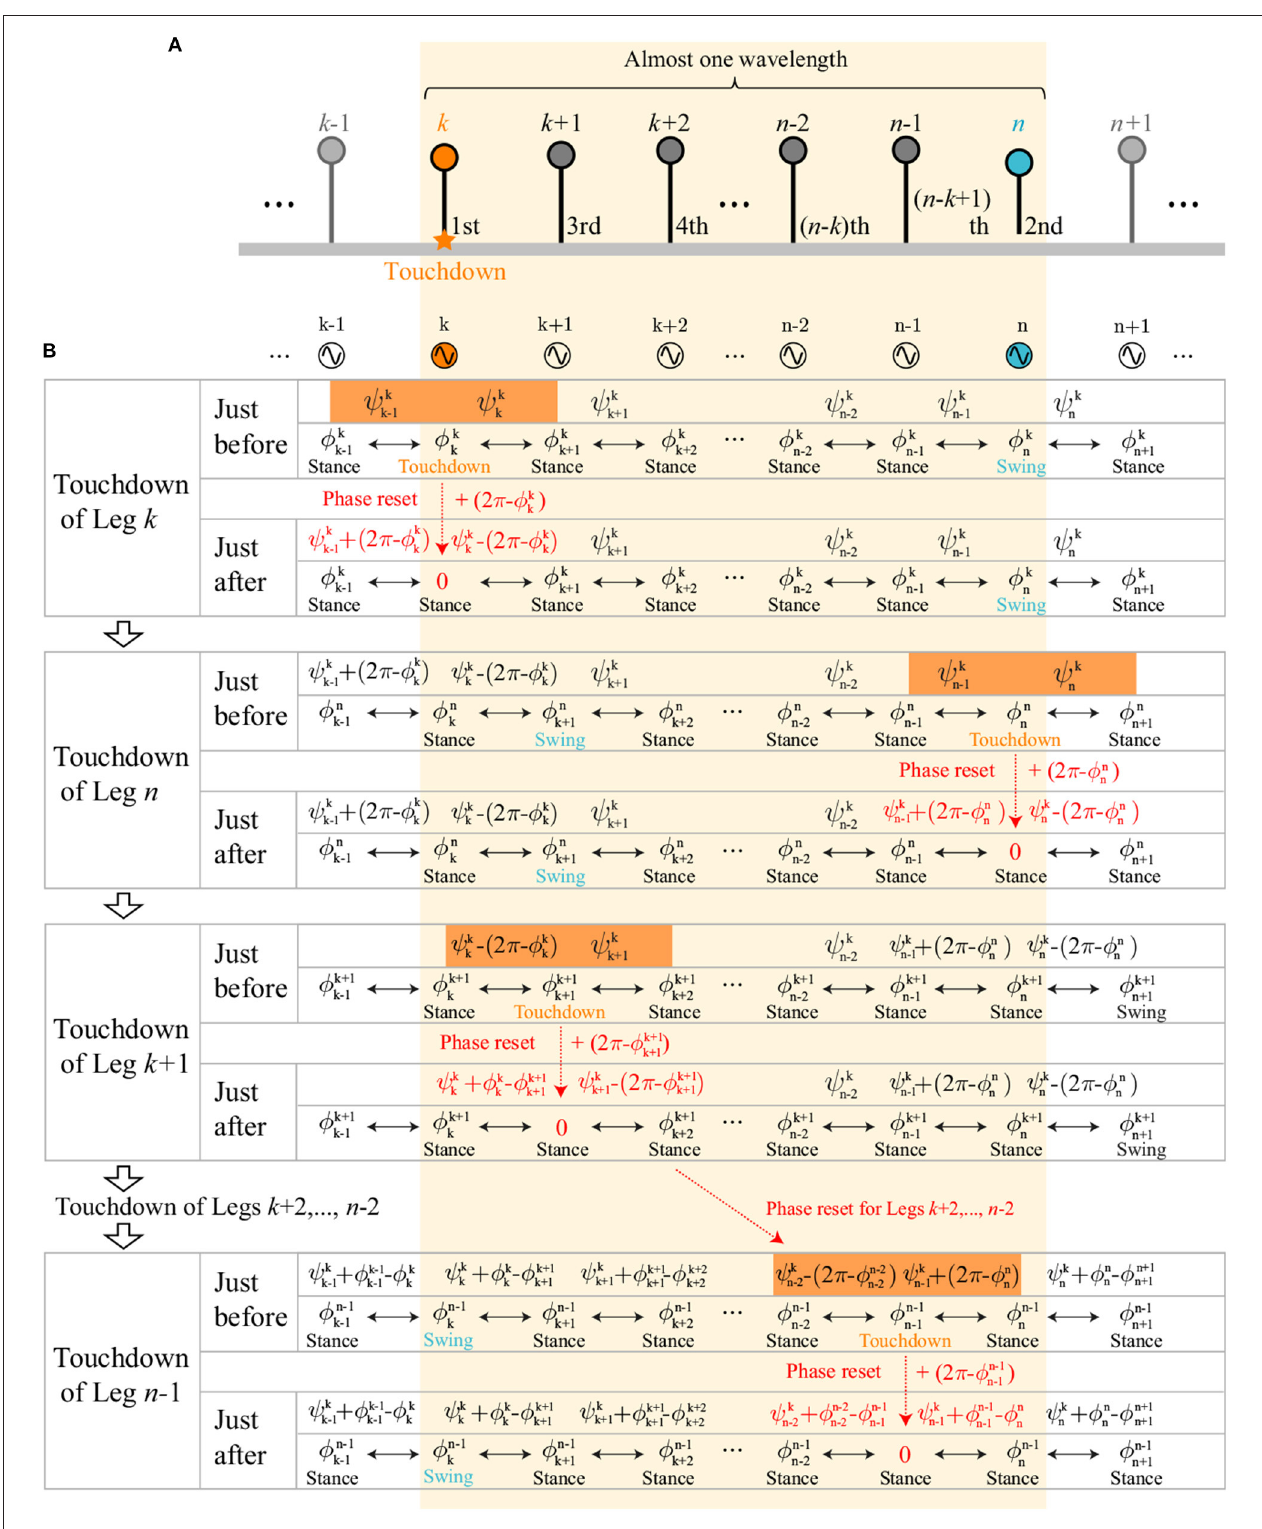
FIGURE 9 | Evolution of oscillator phases within one wavelength: (A) Order of touchdown events of Legs k to n in the retrograde-wave region. Legs k , n , k k 3, ... , n 1 touch down sequentially. (B) Evolution of oscillator phases and relative phases at touchdown events of Legs k to n . Phase resetting at each touchdown + − changes only the oscillator phase of the touchdown leg and the relative phases of the neighboring legs. ψ i i k , n , k ( i 1, k 2, ... , n 2, n 1) are represented by 9 k , φ i − 1 i = + + − −